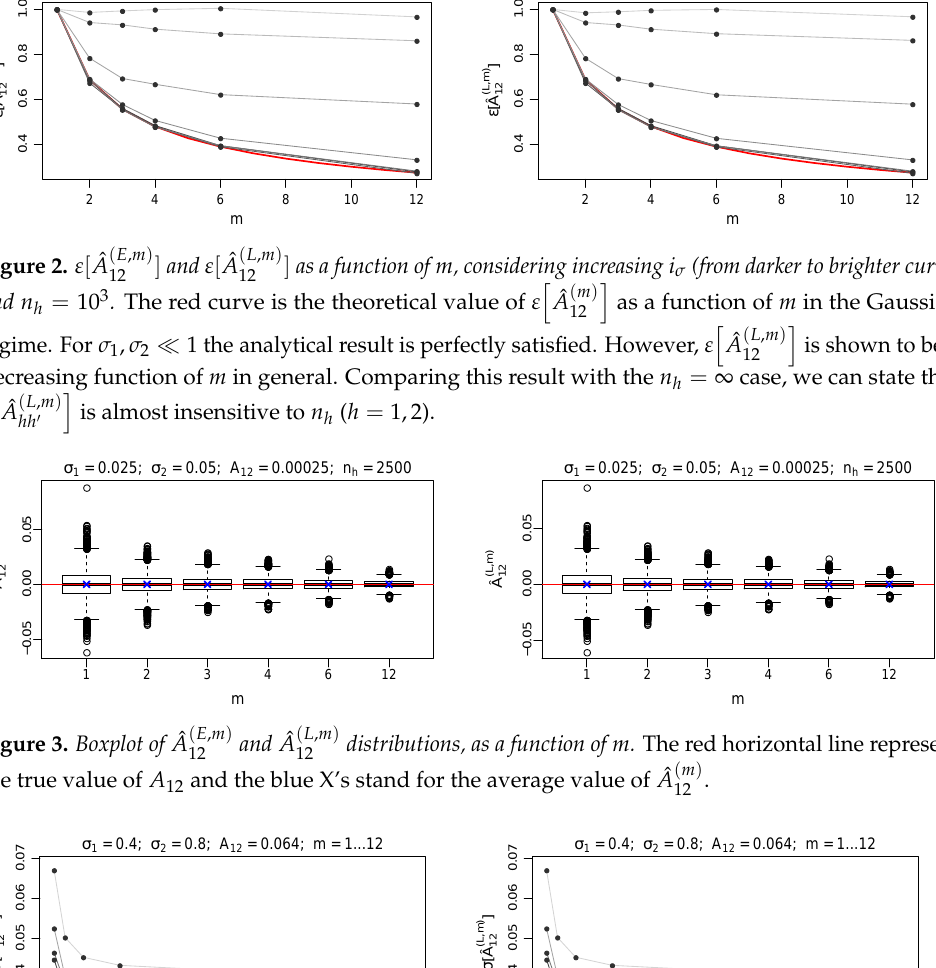
This fact is confirmed by the results shown in Figure 4, where the estimates of σ have been arranged as functions of n h at fixed σ Γ and m values. As expected, the standard error is greater when considering smaller n h values, while the dependence on n h of the error disappears quickly as approaching n h → ∞ .